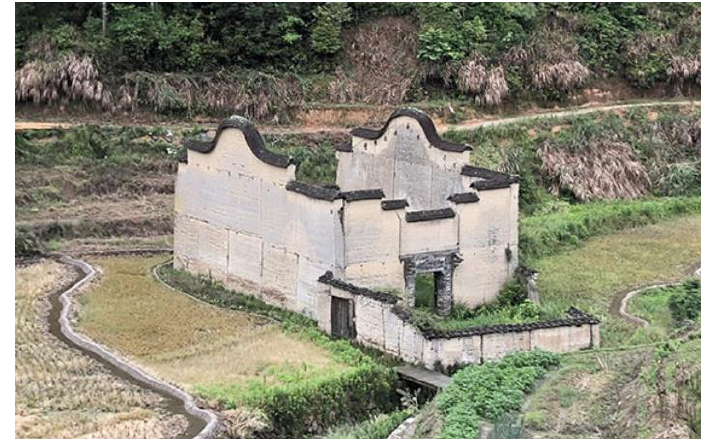
Figure 23. The Paddy Bookstore before transformation (source: [50]).